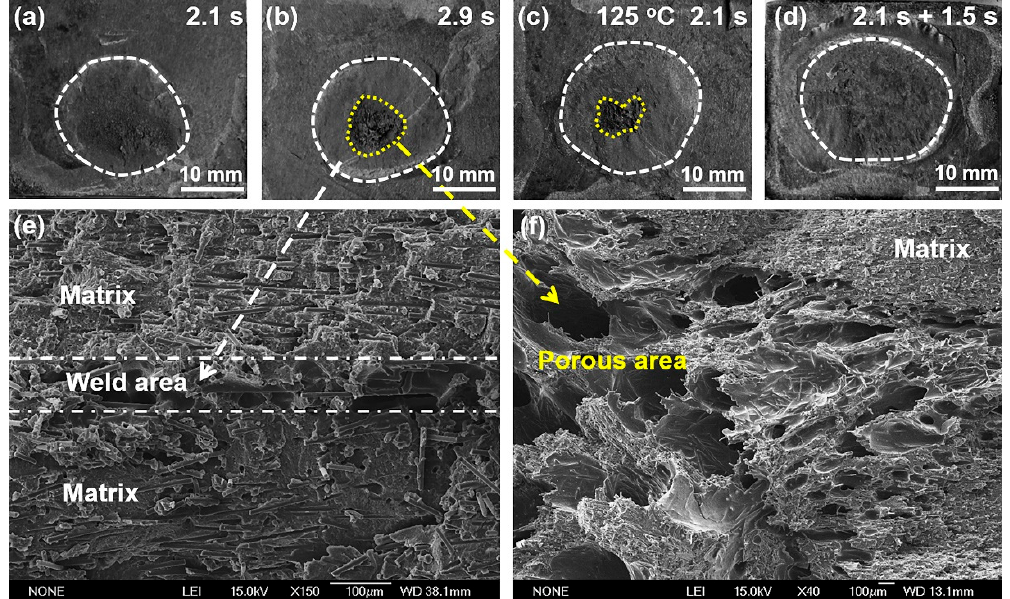
Figure 7. Morphologies of fractured surfaces: ( a ) 2.1 s weld time; ( b ) 2.9 s weld time; ( c ) 2.1 s weld time under preheating temperature of 125 °C; ( d ) DPUWed joint; cross-sectioned joint ( e ) weld area; and ( f ) porous area.